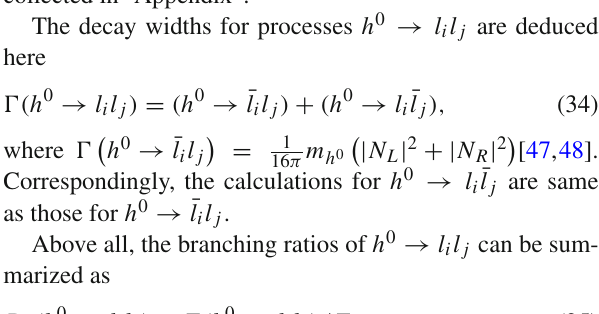
Here, the total decay width of the 125.1 GeV Higgs boson is (cid:10) 4 . 1 × 10 − 3 GeV [18]. (cid:18) h 0 ¯ b and B 0 B 0 meson is made up of d meson is consti- s ¯ b . The present experiment upper bounds for B 0 tuted of s and B 0 meson decays are respectively Br ( B 0 → e + μ − ) < s → e + μ − ) < 1 . 1 × 10 − 8 [18]. New 2 . 8 × 10 − 9 and Br ( B 0 s meson decays emerge at contributions to rare B 0 and B 0 s one-loop level with the box diagrams. In the EBLMSSM, the redefined particles sleptons and sneutrinos lead to new meson decays. So parame- effects to these rare B 0 and B 0 s ters tan β NL and v Nlt may play the dominated roles to the B 0 and B 0 meson decays. π + , K + mesons are respectively com- s ¯ d and u ¯ s . Particle Date Group gives us the present prised of u + ν experiment upper bounds for (π + / K + ) → l j , which are i Br (π + → μ + ν e ) < 8 . 0 × 10 − 3 and Br ( K + → μ + ν e )